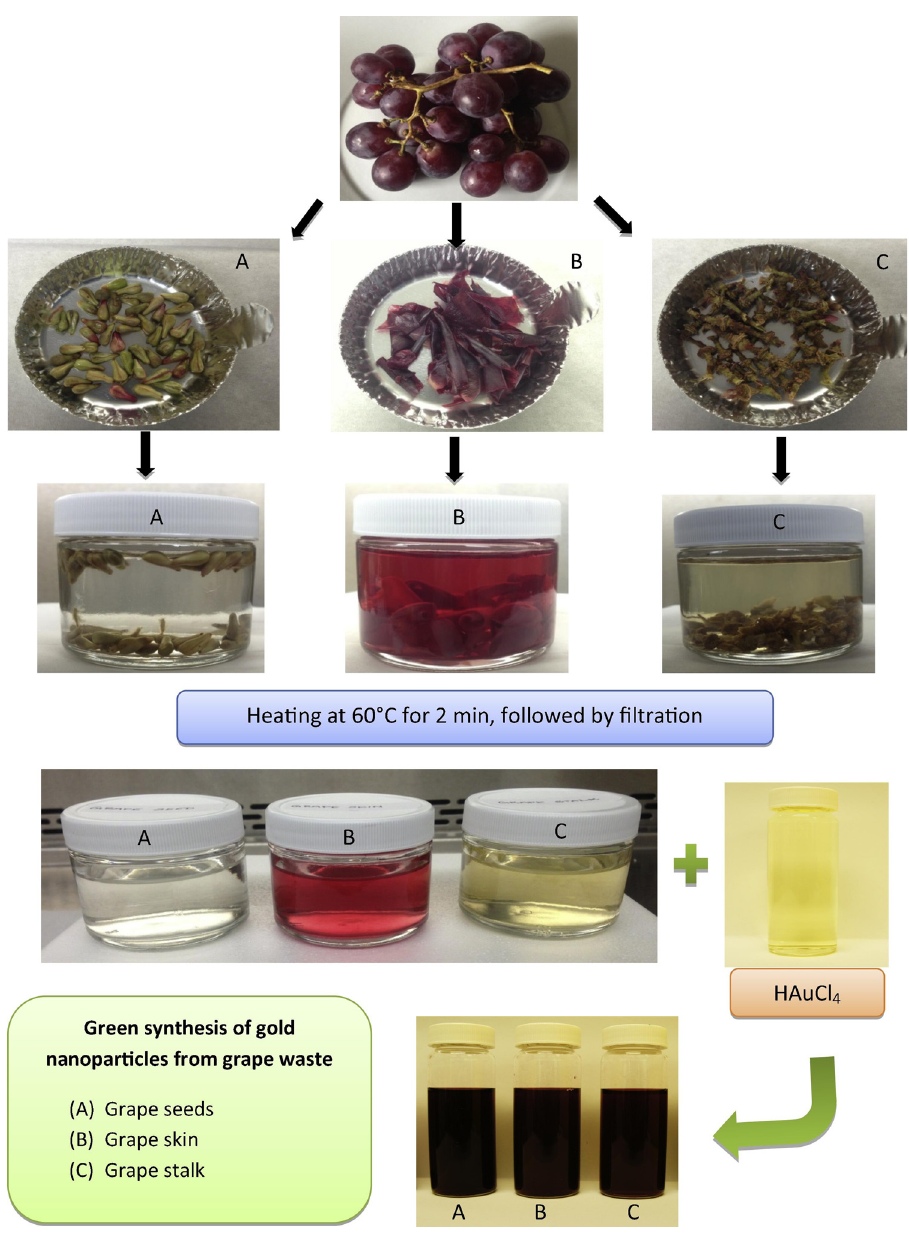
Figure 28: Schematic for AuNPs synthesis. Copied with permission from ref. [ 352 ] ; Elsevier,